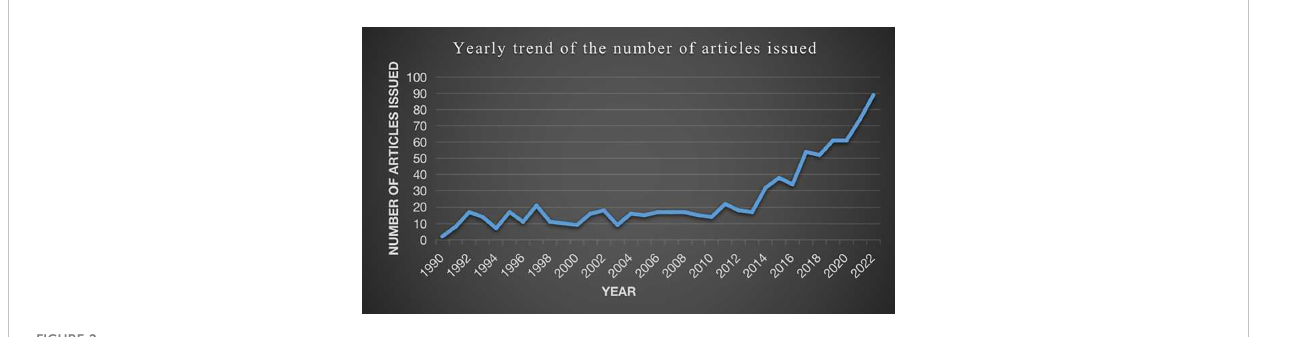
FIGURE 2 Trends in the number of articles published over time in the fi eld of osteosarcoma